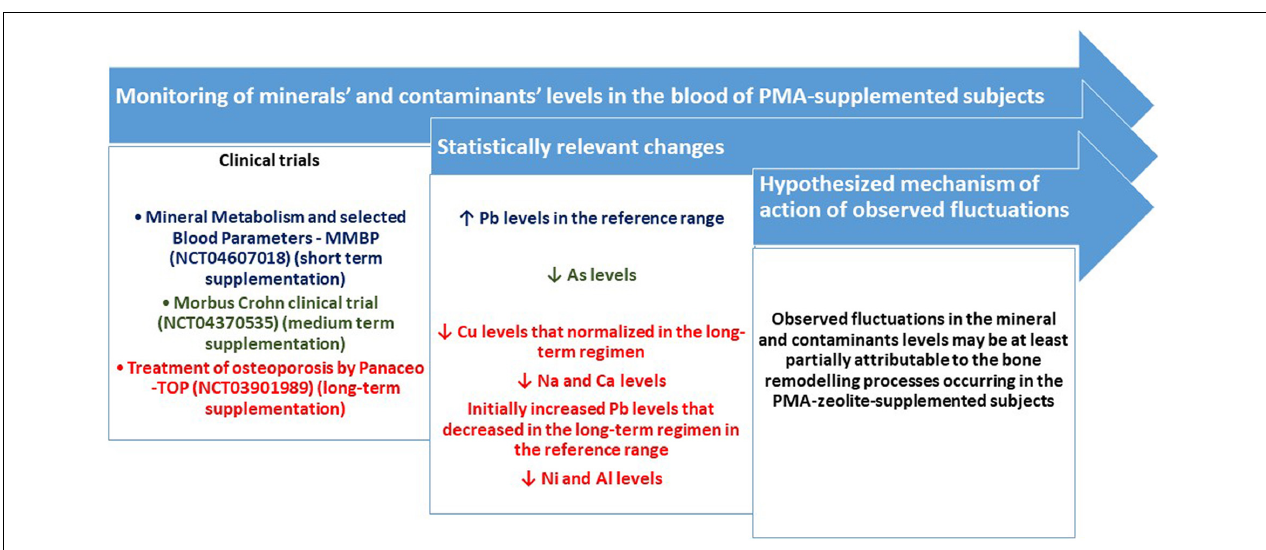
FIGURE 3 | Schematic visualization of the monitoring of minerals’ and contaminants’ levels in the blood of PMA-supplemented subjects and major results listed as statistically relevant changes in particular mineral or contaminant levels ( p <